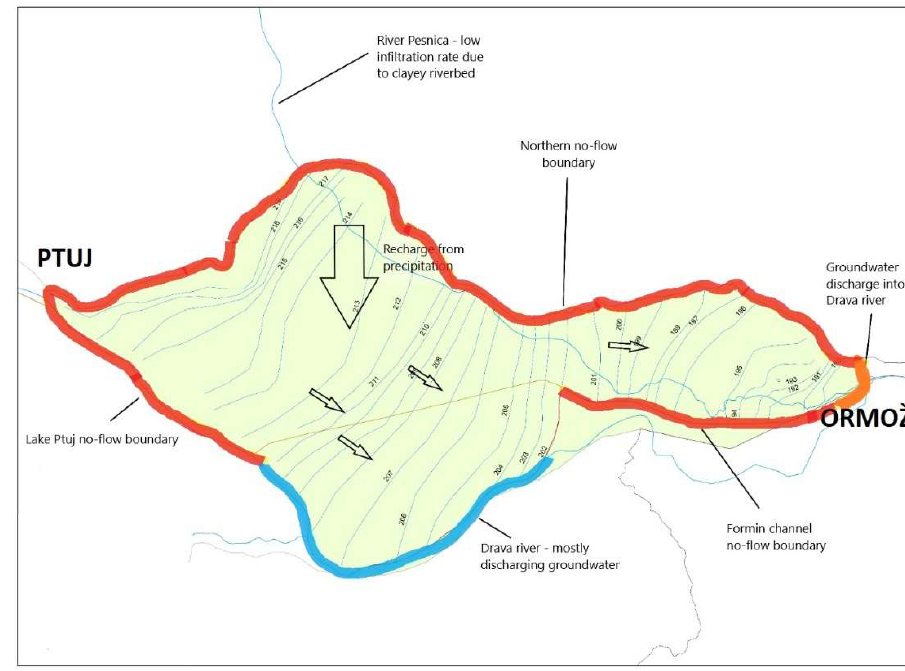
Figure 7. Conceptual model for the Ptujsko polje aquifer.